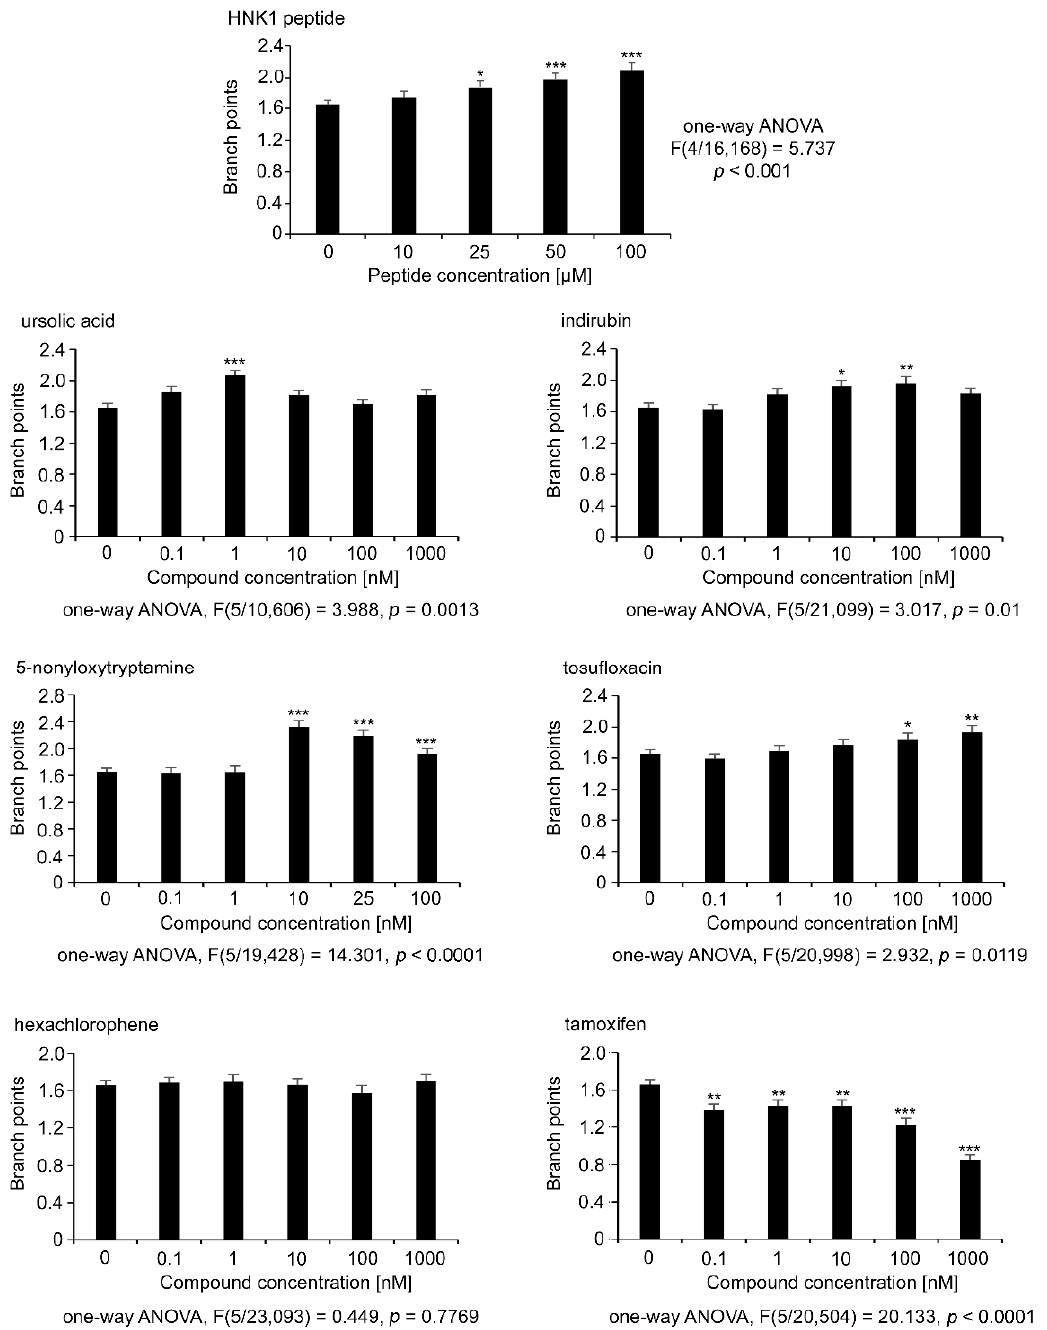
Figure 4. Neurite branch points of motor neurons treated with di ff erent concentrations of HNK1 mimetics as measured with automated InCell analysis. Cultures of motor neurons were treated for 24 h with di ff erent concentrations of HNK1 mimetics or as positive control with HNK1 mimetic peptide. DMSO (0.2%) served as vehicle control (0). Neurite branch points of β -tubulin class III immunostained neurons were counted by the InCell Analyzer. Bar diagrams show the average number of branch points per neurite ( n ≥ 2000 neurons from three independent experiments + SEM). Asterisks show di ff erences in branch points between HNK1 mimetics and the vehicle control (one-way ANOVA; Fisher’s PLSD test, * p < 0.05, ** p < 0.01, *** p <